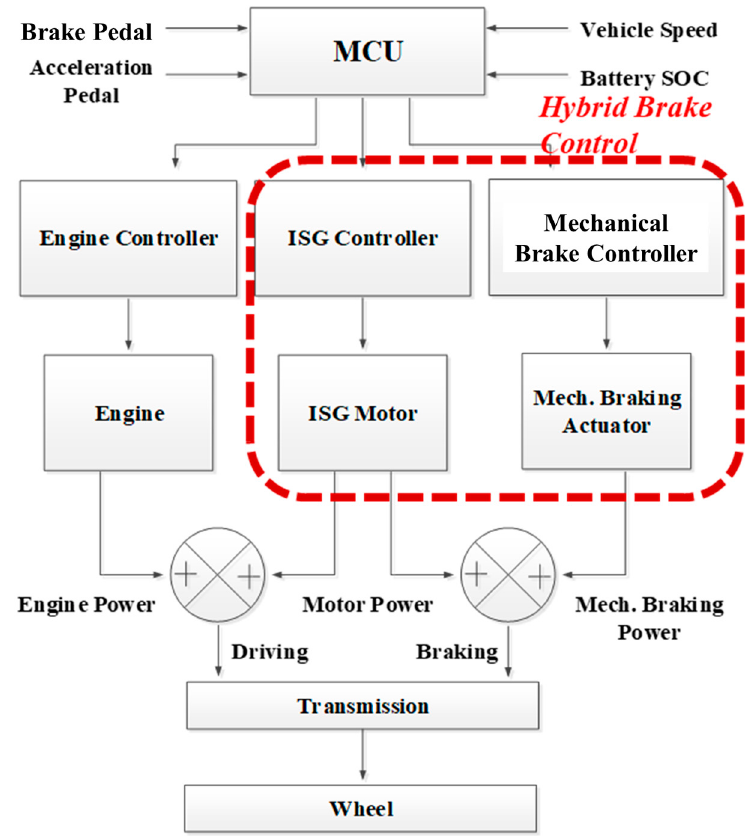
Figure 2. Hybrid brake control method for an ISG.